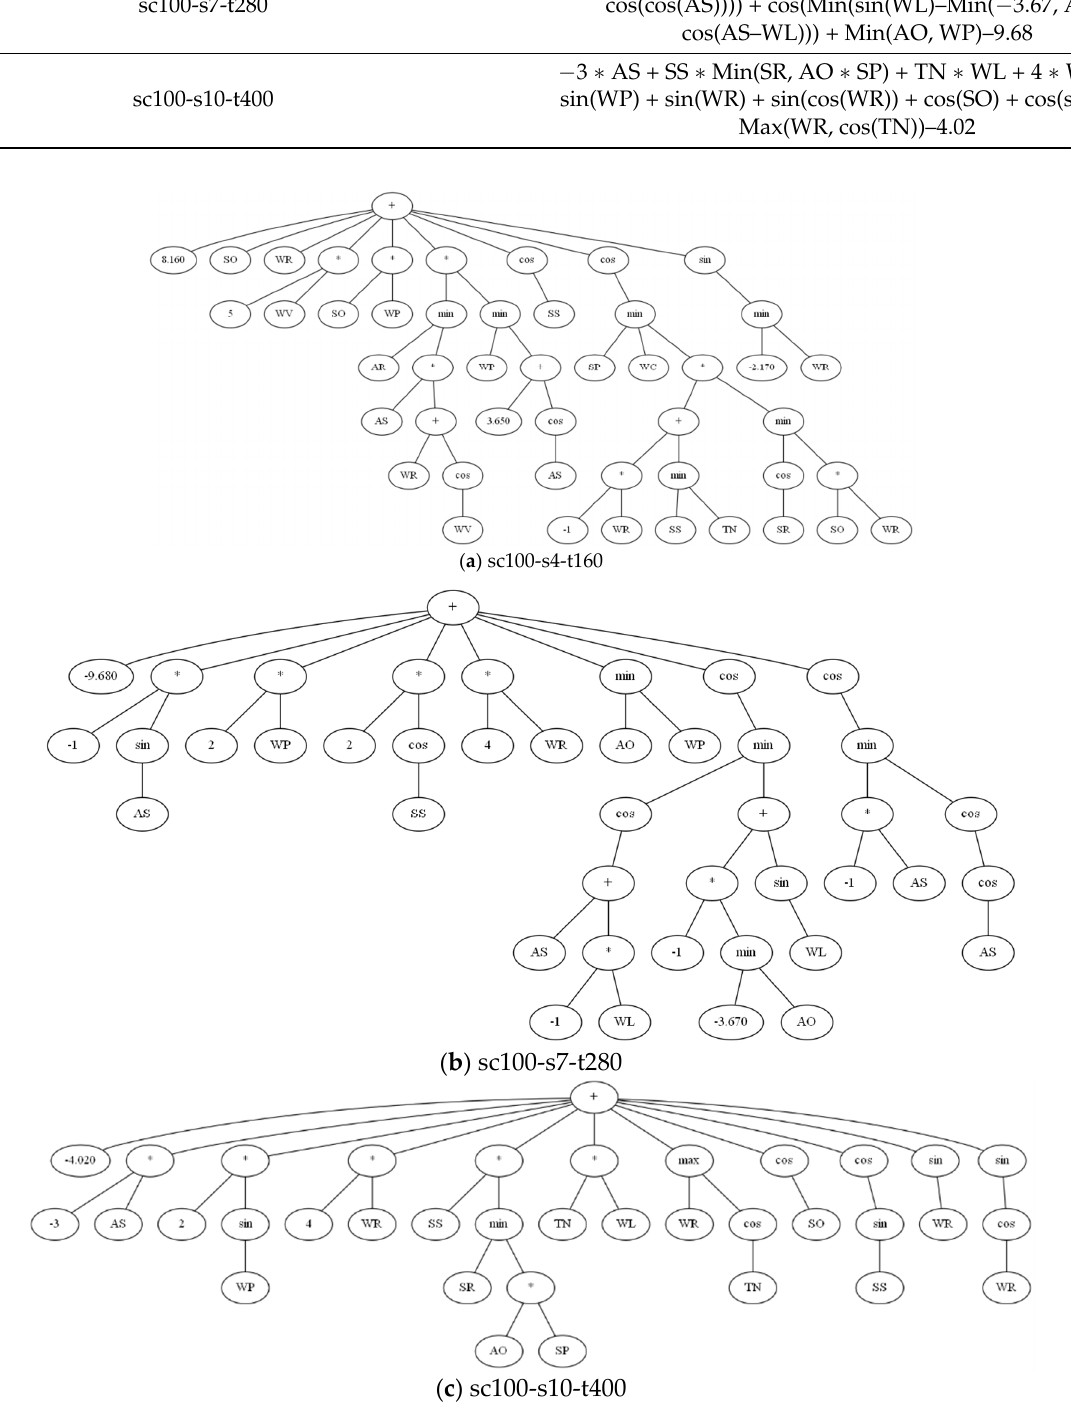
Figure 9. The expression trees of the best dispatching rules.